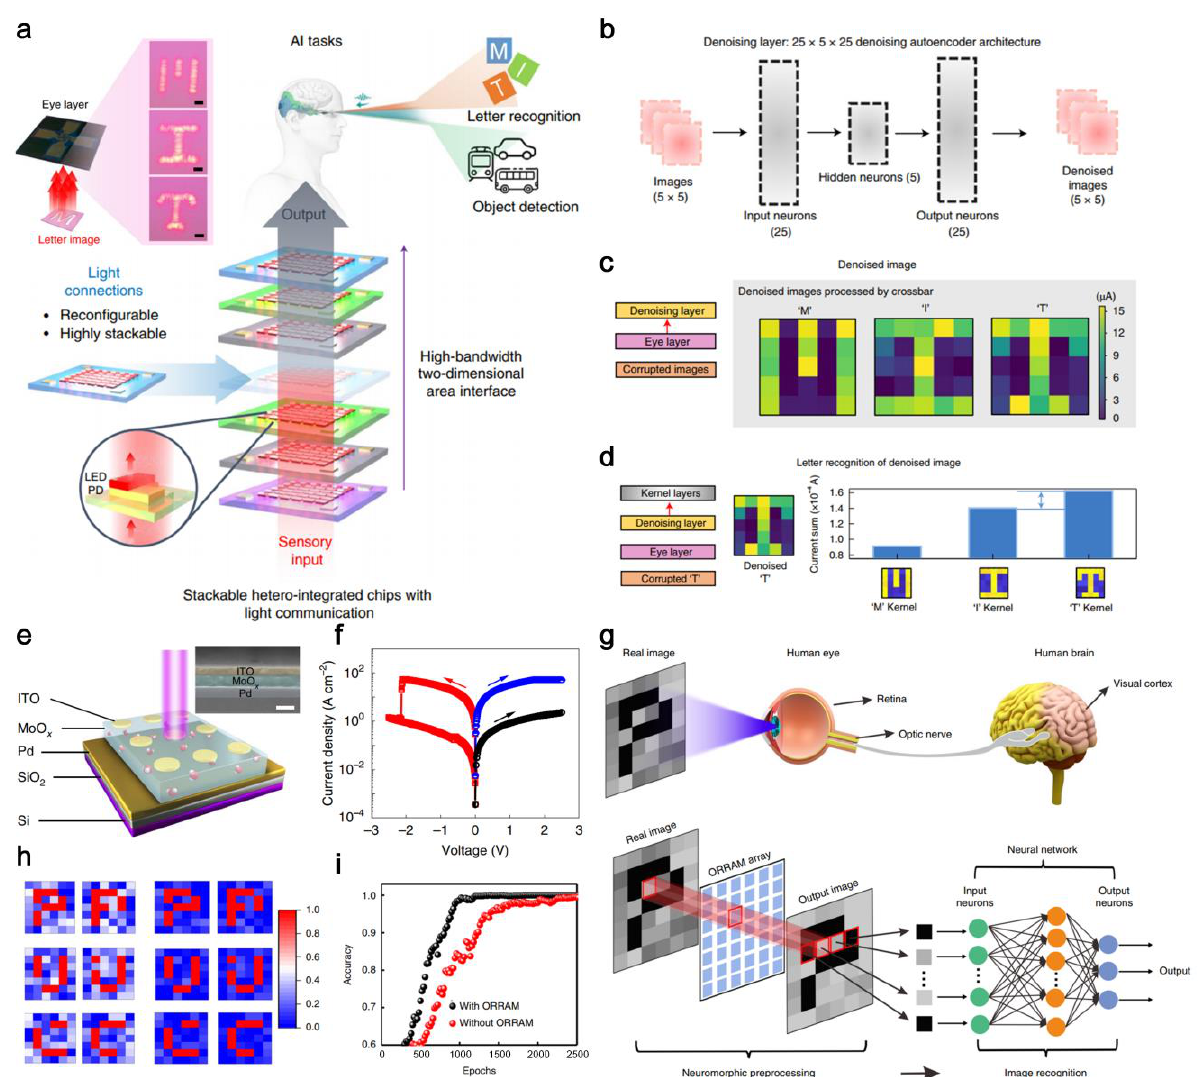
Figure 10. ( a ) Schematic of reconfigurable heterointegrated AI-embedded neuromorphic chips. A light source from the bottom through a letter image (“M”, “I”, and “T”) can be sensed by the eye layer. The fabricated neuromorphic chip connected to a light communication system (sensory input) is illustrated as a stackable heterointegrated chip. In the eye layer output, through AI tasks,